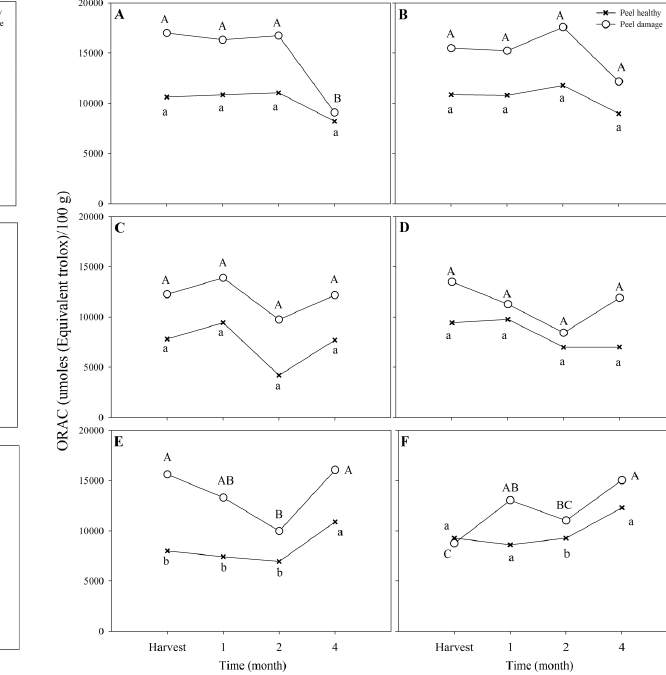
Fig. 3: Evolution of ORAC in apple peel from cv. Brookfield ® (A and B), Granny Smith (C and D) and Fuji (E and F), from harvest to 4 months of cold storage from conventional (A, C and E) and organic (B, D and F) orchard, in healthy and sun-burned apple.